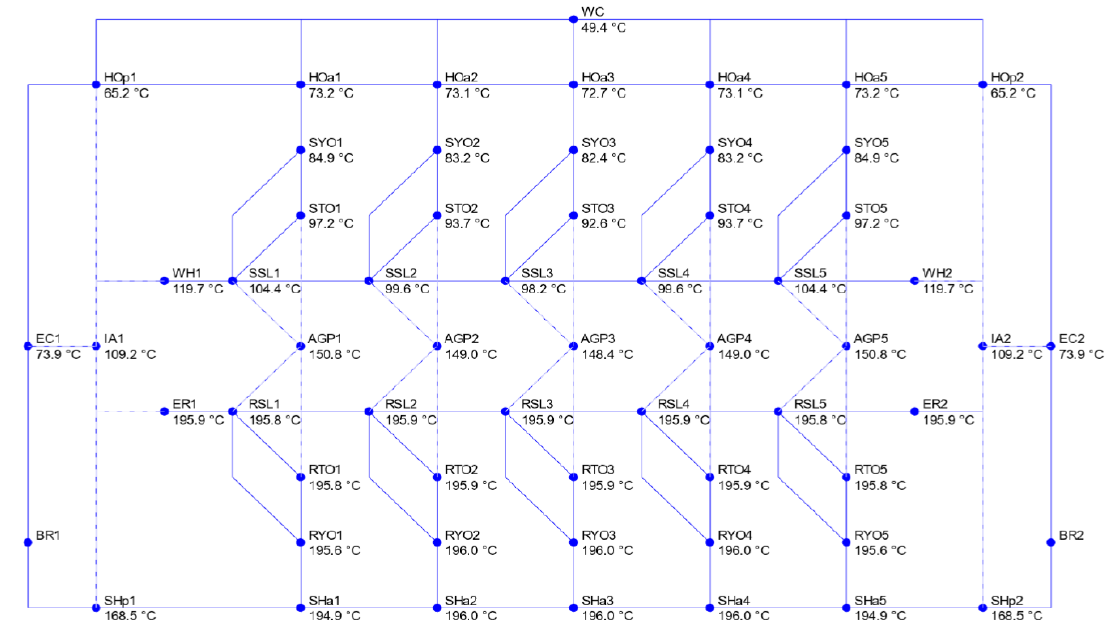
Figure 11. Thermal modeling results of the IM for the NEmo at 1500 r/min and 103 N·m.